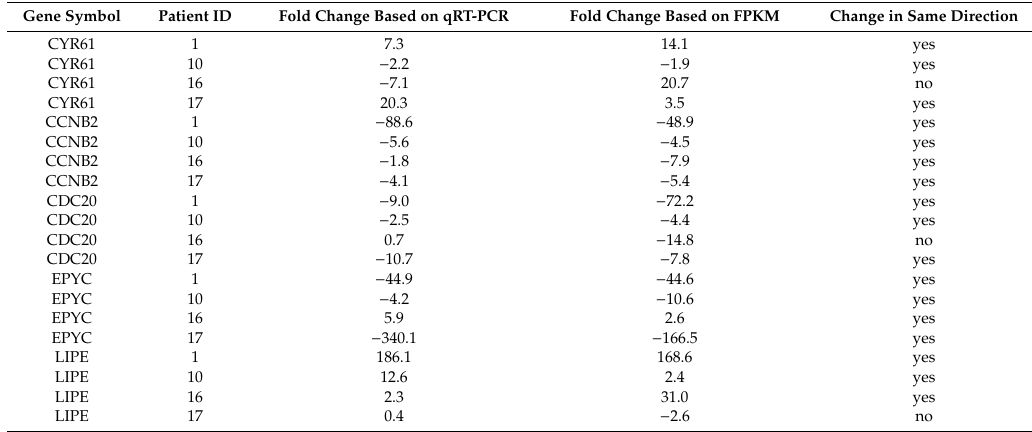
Table 5. Comparison of qRT-PCR results with RNA sequencing